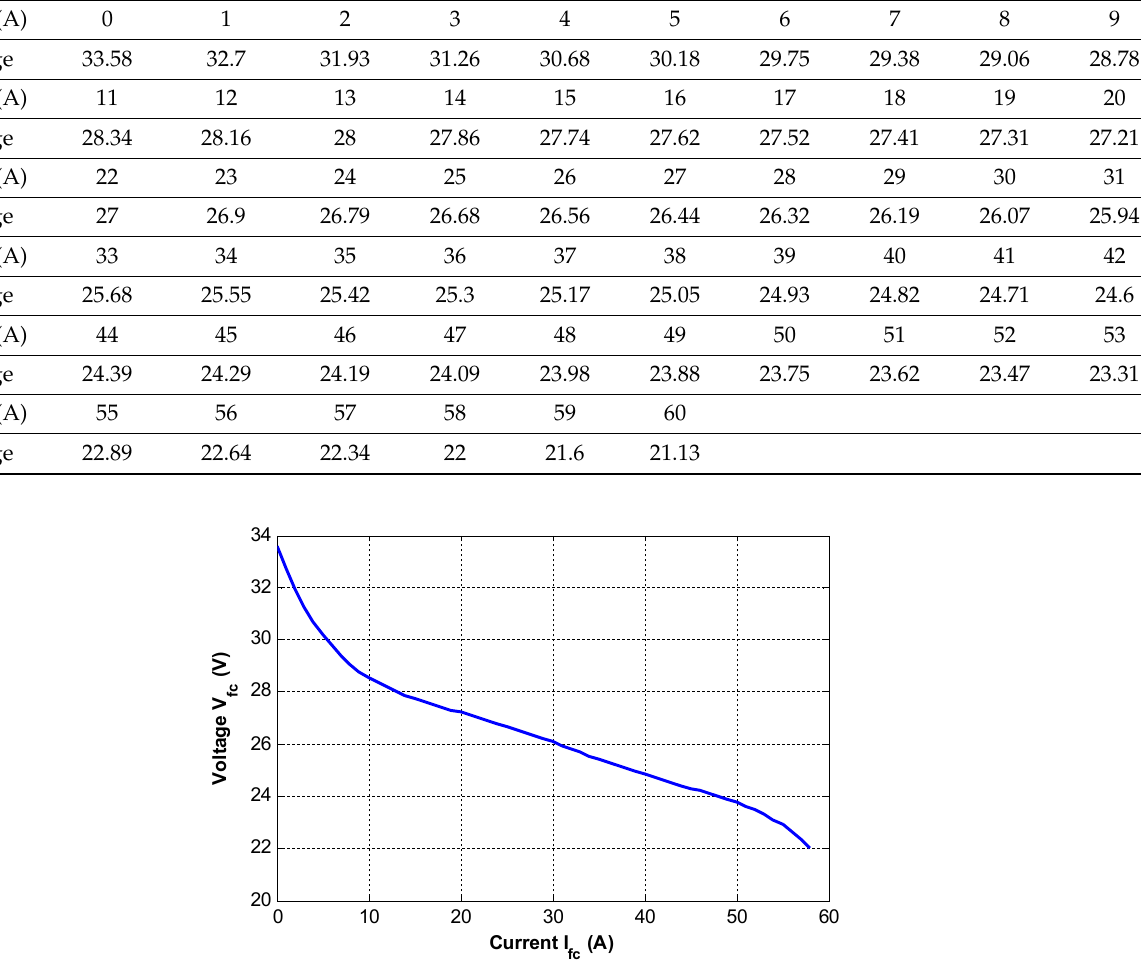
Table 1. Experimental data of the fuel cell current and voltage.